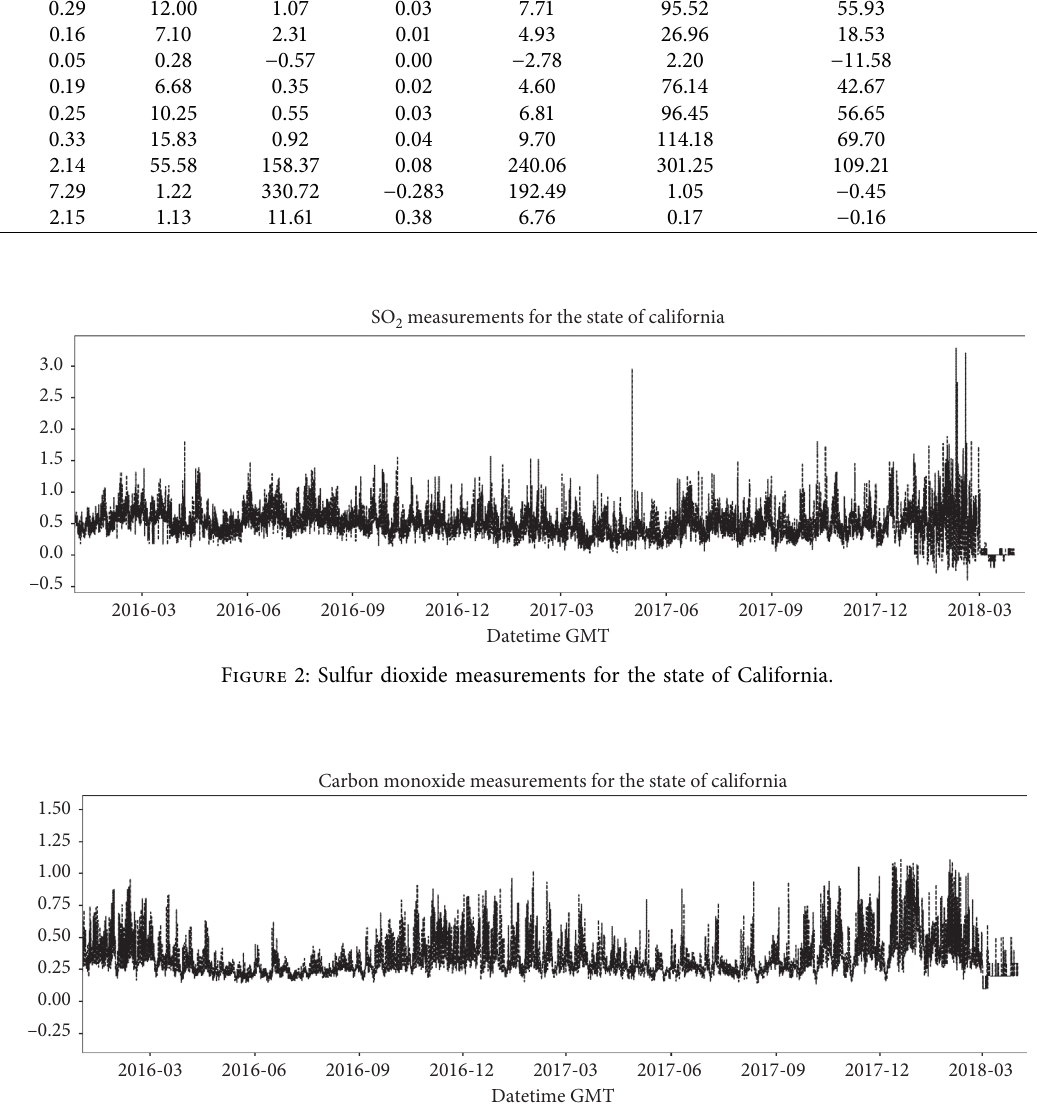
Figure 3: Carbon monoxide measurements for the state of